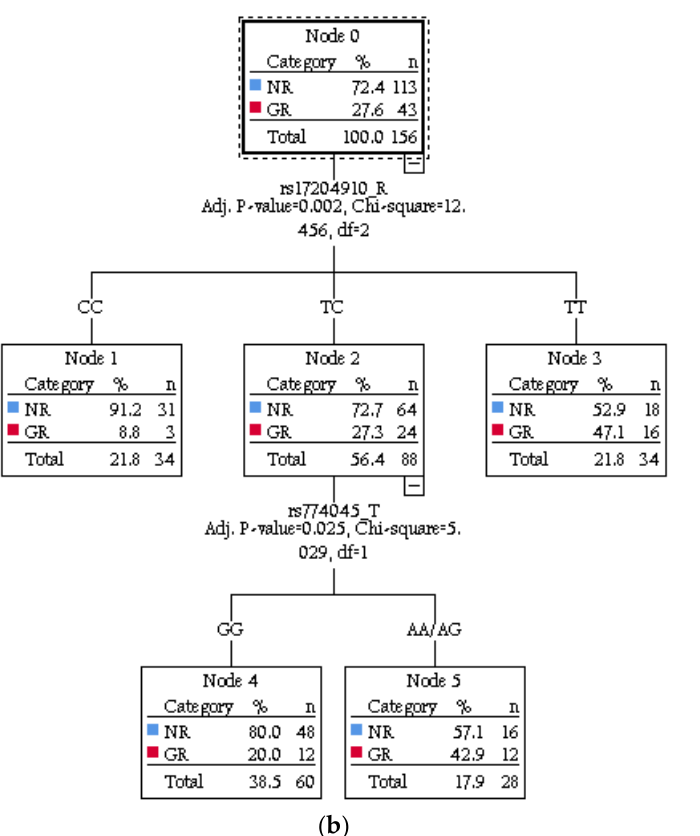
Figure 2. Classification tree models for Li response phenotypes (NR = non-response; GR = good response) and genotypes of candidate circadian genes (rs17204910-R: RORA ; rs774045-T: TIMELESS ). ( a ) Classification tree using the original categories (Alda Cats). ( b ) Classification tree using the machine learning algorithm (Algo).